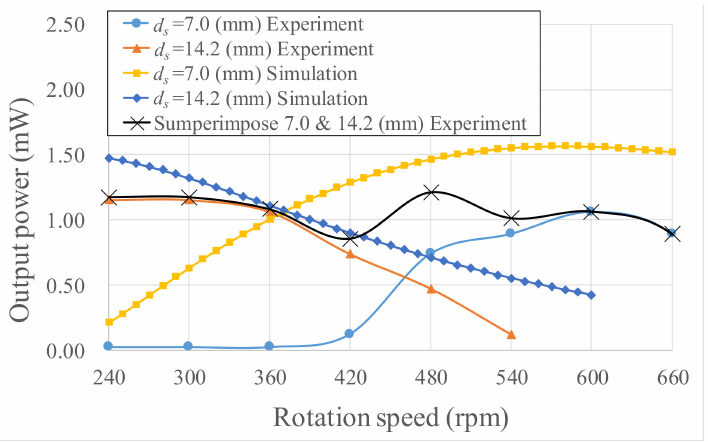
Figure 23. Simulated and experimental power of the proposed energy